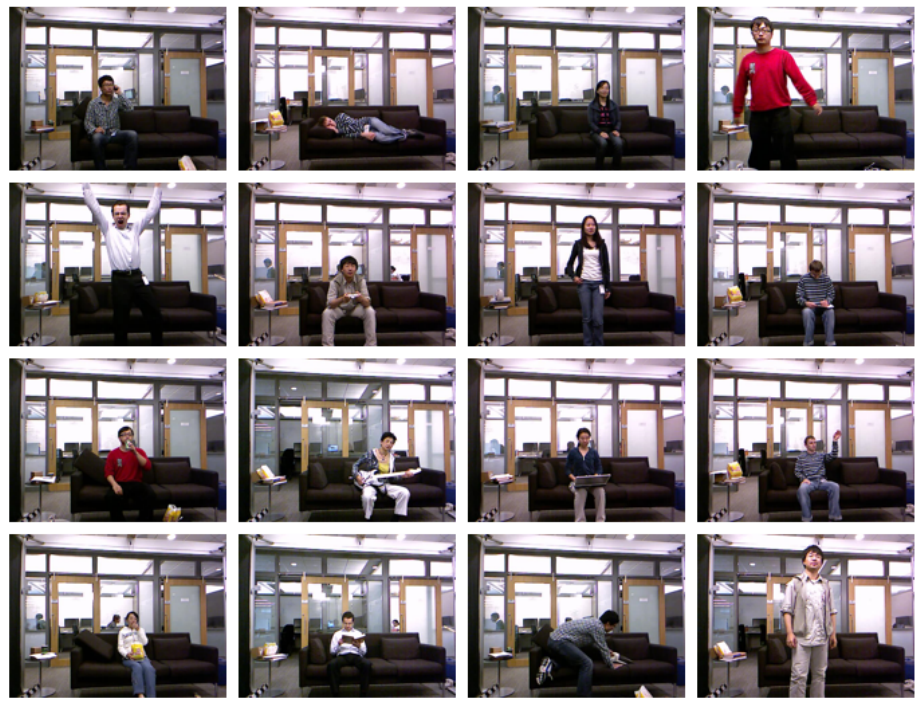
Figure 6. Frames from exemplar sequences of the Microsoft Research (MSR) 3D daily activity database